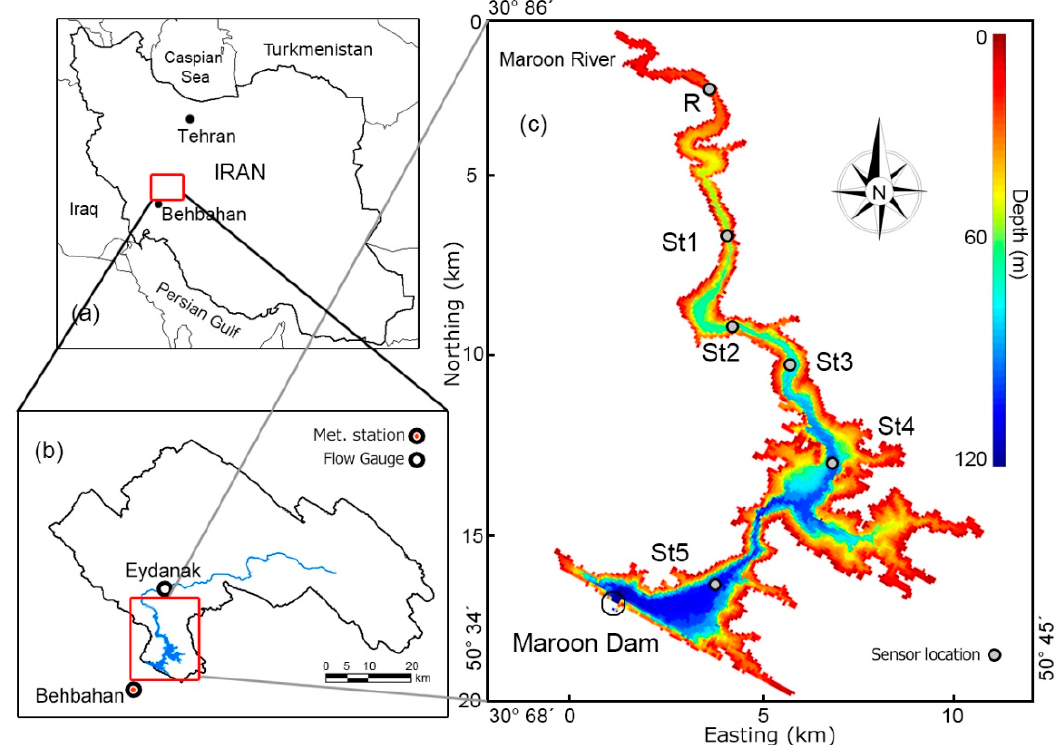
Figure 1. ( a ) Orientation map of the Maroon Reservoir; ( b ) Maroon Reservoir catchment and location of the Behbahan synoptic and Eydanak rain gauge stations; ( c ) Maroon Reservoir bathymetry and sensor locations.